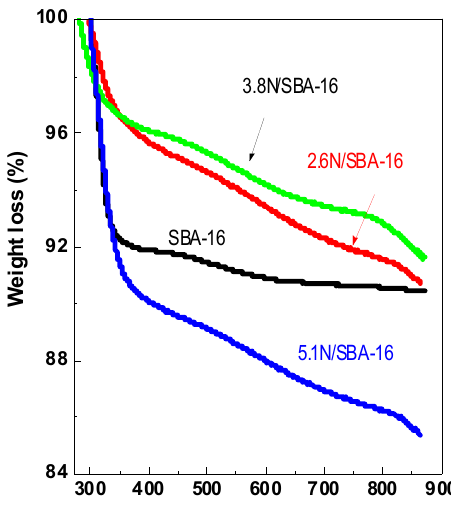
Figure 5. Thermogravimetric curves of SBA-16, 2.6N/SBA-16, 3.8N/SBA-16, and 5.1N/SBA-16 adsorbents.